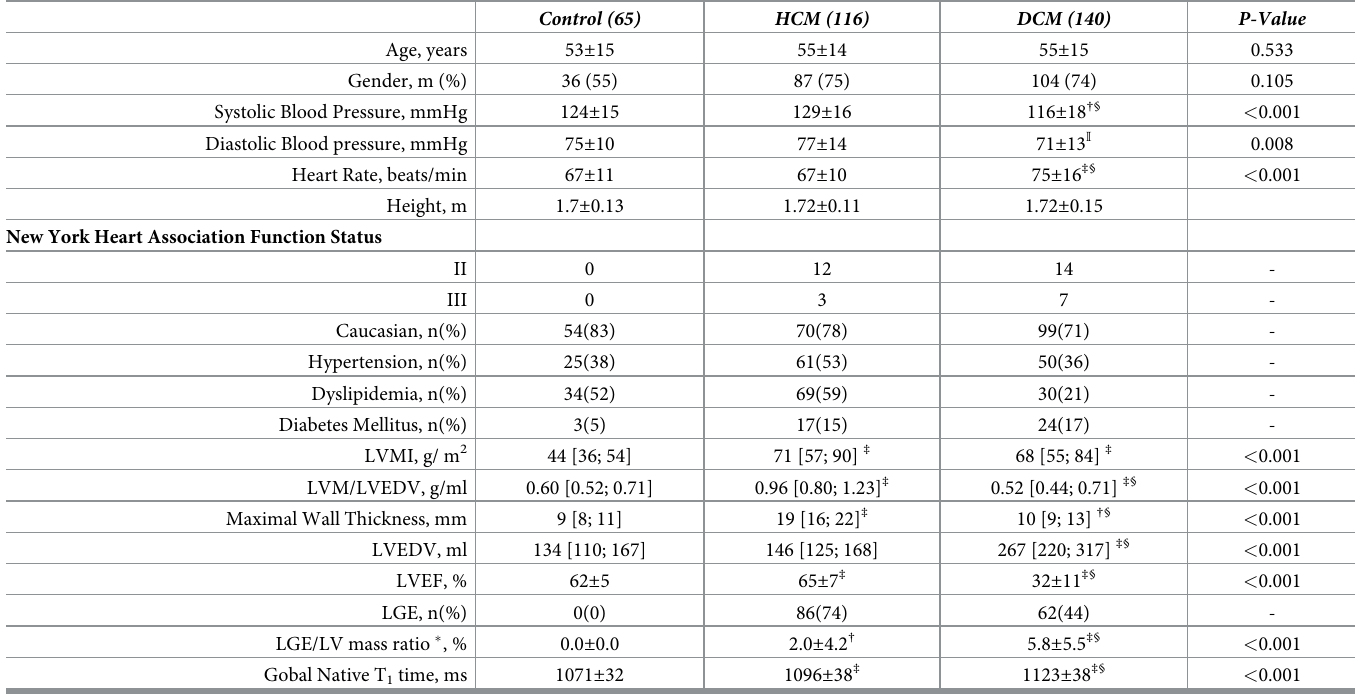
Table 2. Cohort characteristics and standard cardiac MR measures of function and